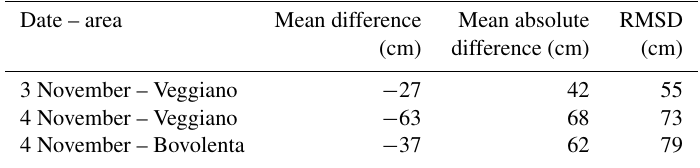
Table 3. Comparison between flood depth obtained with the hydrodynamic model and the proposed